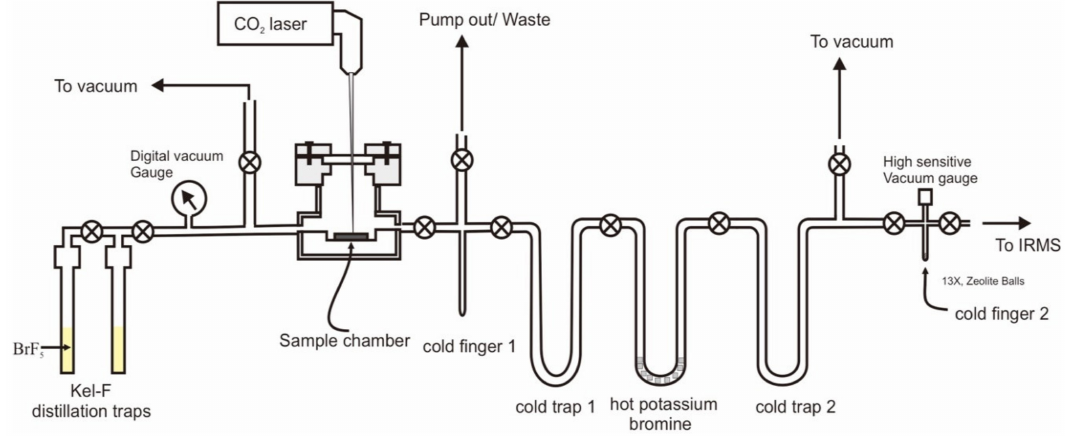
Figure 2. BrF 5 laser oxygen isotope fluoridation preparation